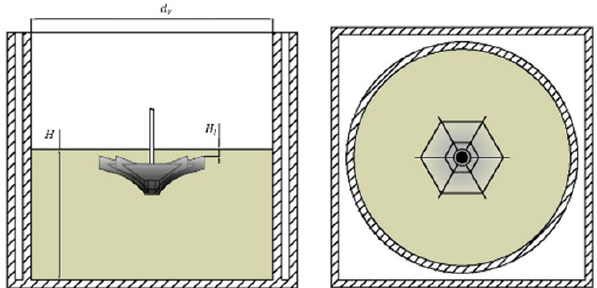
Figure 2. Schematic diagrams of the aeration tank and impeller.